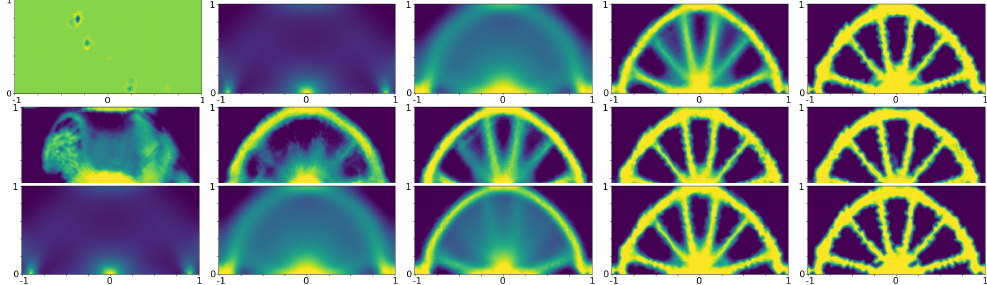
( ϕ n ) ( center row ) in comparison with ϕ LSTM